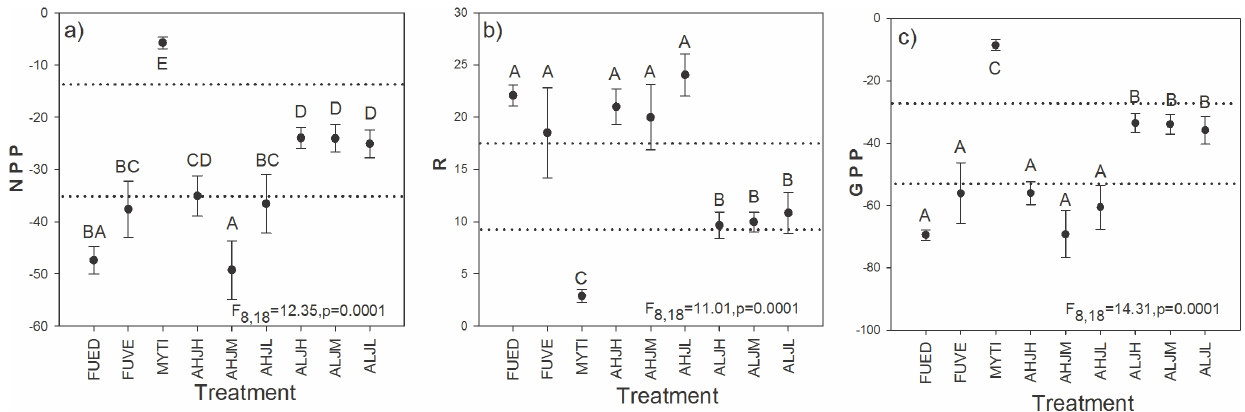
Figure 3. Average ( ± SE) values of productivity variables ( m molCO 2 *mlO 2 2 1 *min 2 1 ) of a) Net primary production (NPP), b) community respiration (R) and the c) gross primary production (GPP). Measurements were taken in July 2011 from each treatment and from 3 randomly chosen replicates (see Methods). The dotted lines represent the confidence interval ( 6 95%) of the production done on natural community (see results section for details). Levels not connected by the same letter are significantly different. See Table 1 for the details of the treatment.